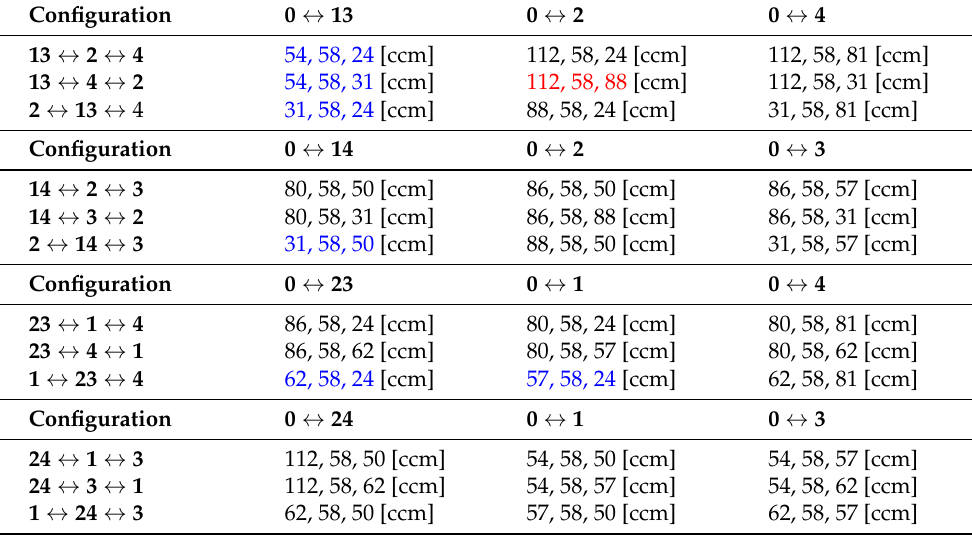
Table 7. Necessary displacements for linear VDN topology interconnection schemes with shared chambers in crane application. The Blue colored cases mark the schemes with displacement sums below 150 [ccm] and the red colored case marks the scheme with the highest displacement